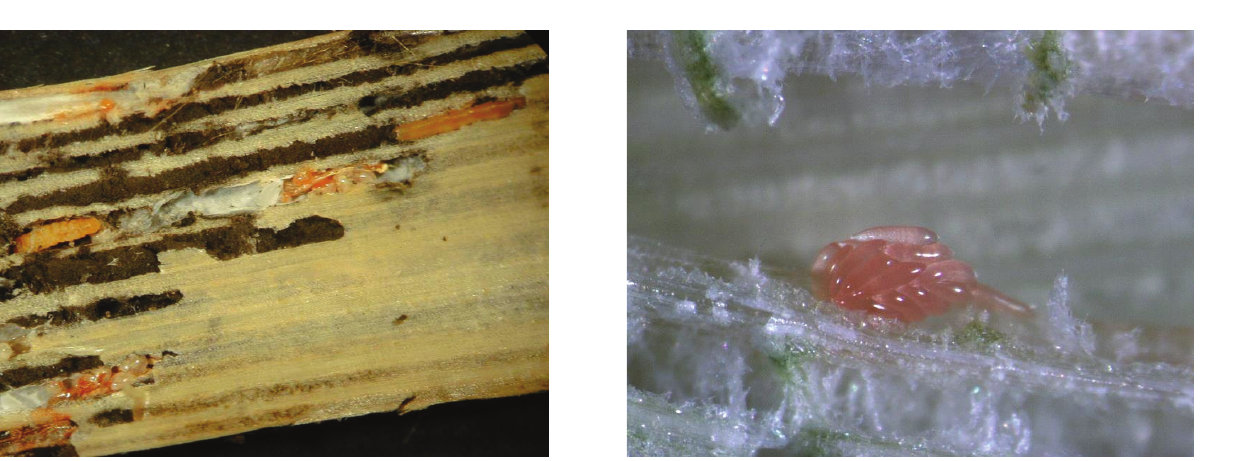
Figure 2: Third instars are found with the ambrosia fungus, a brown yeasty material, in the mesophyll layer of Arundo donax. Note the silken cocoons at center and upper left.